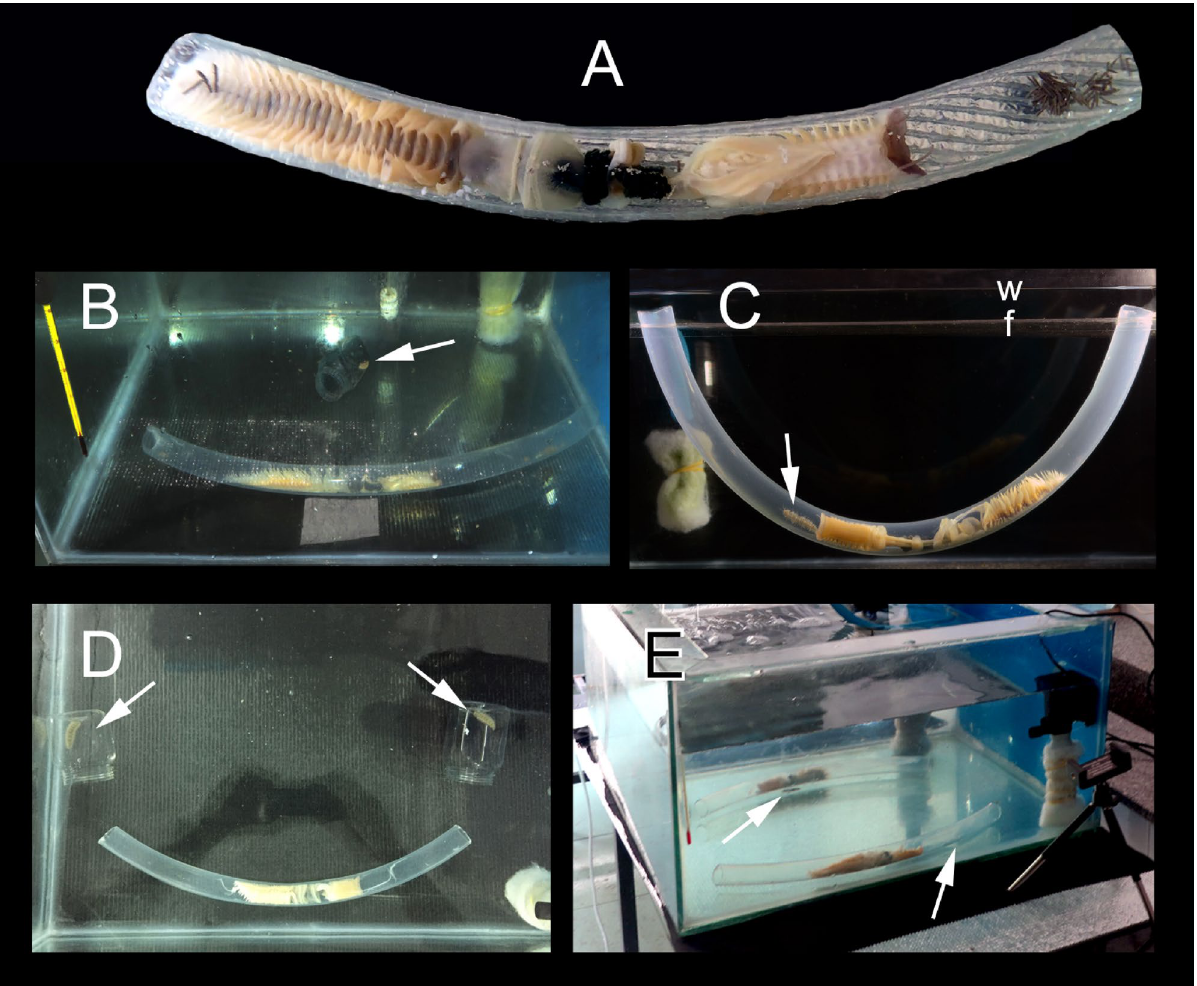
Figure 8. ( A ) Chaetopterus cf. appendiculatus inside a transparent plastic tube. ( B ) Experimental aquarium with one host in a plastic tube and one symbiont. ( C ) Experimental aquarium with perforated false bottom and a fixed plastic tube containing one host and two symbionts. ( D ) Manipulating competitor-to-resource ratio (CRR) experiment, CRR = 2 treatment (one host, two symbionts) . ( E ) CRR manipulative experiments, CRR = 1 treatment (two host, two symbionts) . White arrows pointing on symbionts’